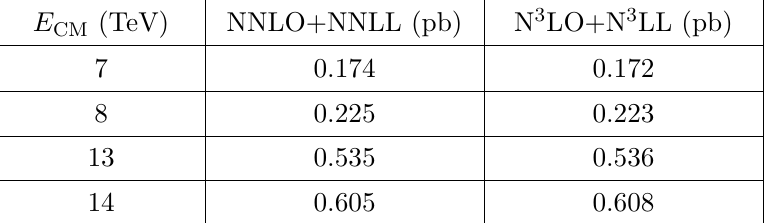
Table 2 . Resummed cross-sections are provided for 7 ; 8 ; 13 ; 14 TeV LHC with PDF4LHC2015nnlo pdf set for the central scale choice ( (cid:22) c